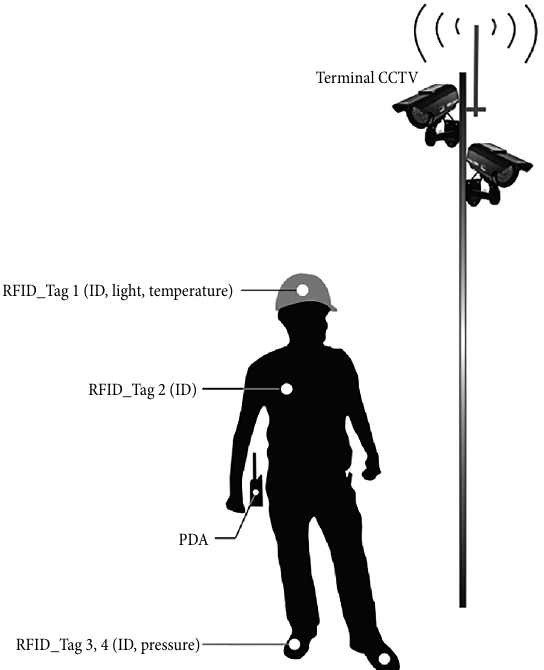
Fig. 2. Checking the proper usage of the worker’s PPE at the terminal by means of CCTV – adapted from Sole et al. (2013a)